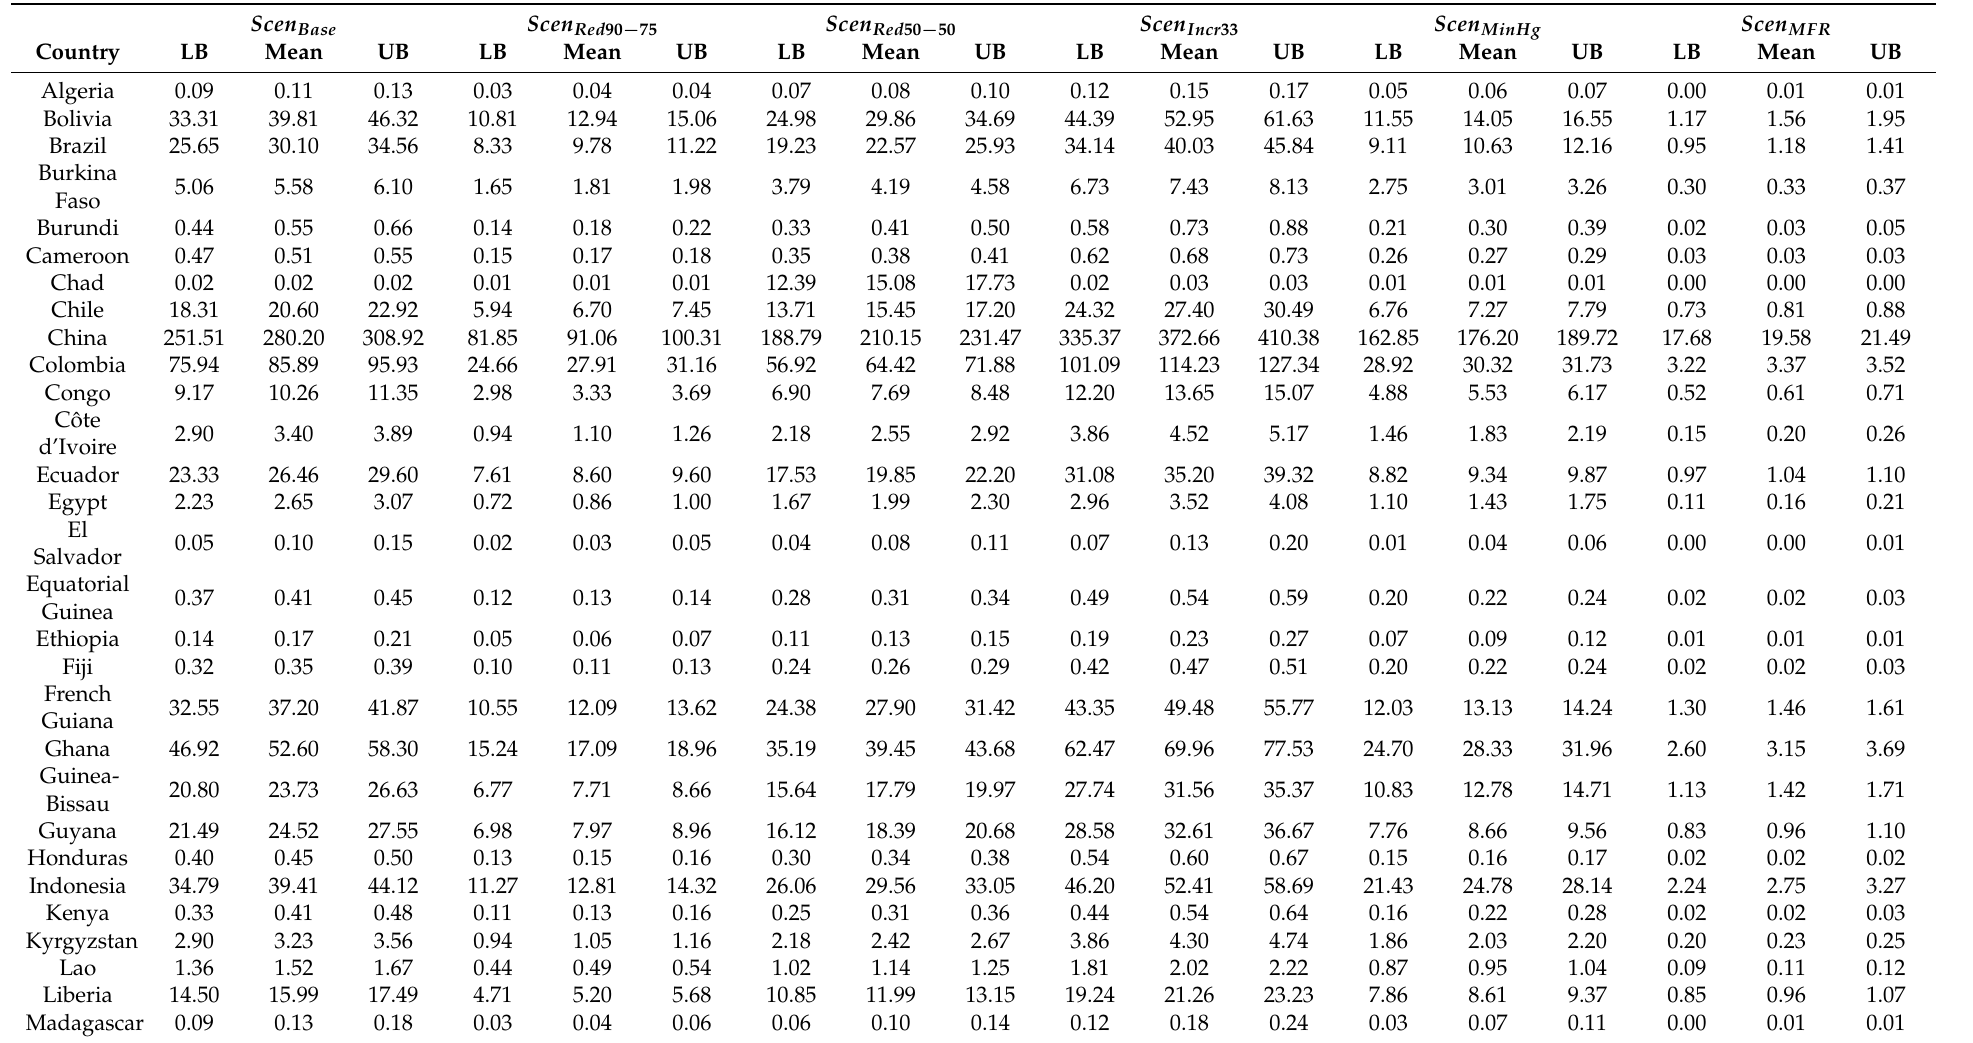
Table 3. Summary of the Hg emissions from ASGM estimated in this study in the different Hg emission scenarios